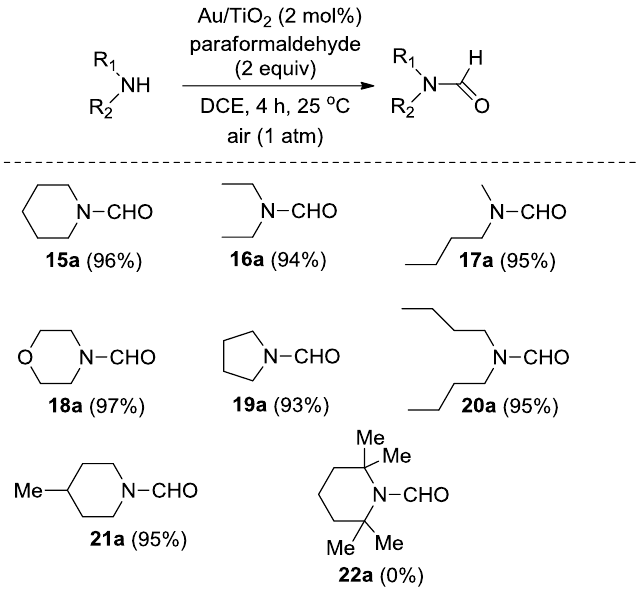
Figure 2. N -Formylation of secondary amines via oxidative coupling with paraformaldehyde catalyzed by Au/TiO 2 .